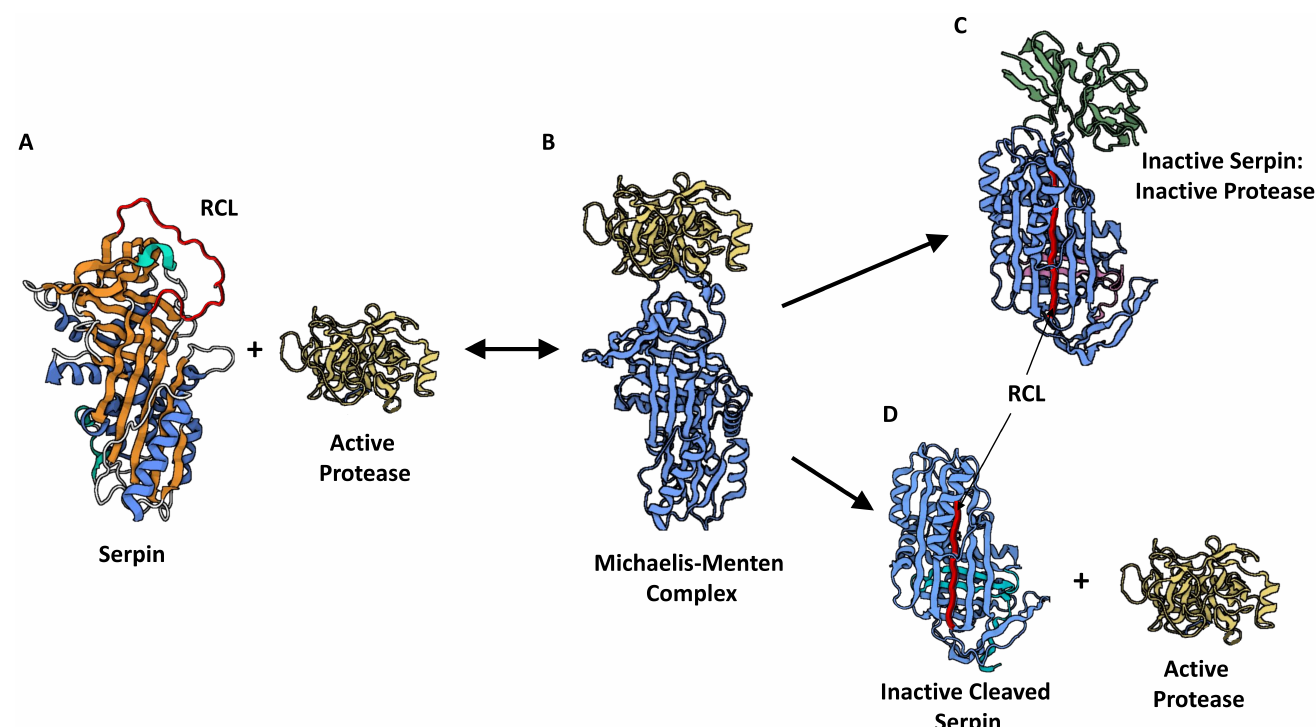
Figure 2. The inhibitory or alternative substrate mechanisms of serpin-protease interaction. ( A ) The metastable native serpin exists with its reactive centre loop (RCL) exposed as a pseudo-substrate for its target protease (PDB code: 1QLP). ( B ) The target protease binds to the P1 site located on the RCL forming a Michaelis-Menten complex (PDB code: 1OPH). ( C ) The target protease cleaves the target scissile bond inducing a dramatic conformational shift in the serpin resulting in the formation of a covalent serpin-protease complex where the RCL is pulled down into the centre of the serpin molecule and incorporated into β -sheet A, subsequently trapping and inactivating the covalently bound target protease (PDB code: 1EZX). ( D ) The “substrate” pathway will be favoured if the reaction does not occur rapidly enough. The protease escapes the conformational trap resulting in an inactive cleaved serpin and a free active protease (PDB code: 7API). PDB code 1QLP was accessed on 25 March 2021; 1OPH, 1EZX and 7API were accessed on 21 April 2021. Created with